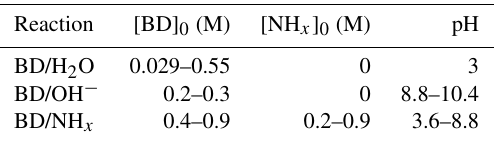
Table 1. List of experiments performed, according to reaction. pH ranges and initial butenedial (BD) and NH x concentrations are pro- vided. Reaction [BD] 0 (M) [NH x ] 0